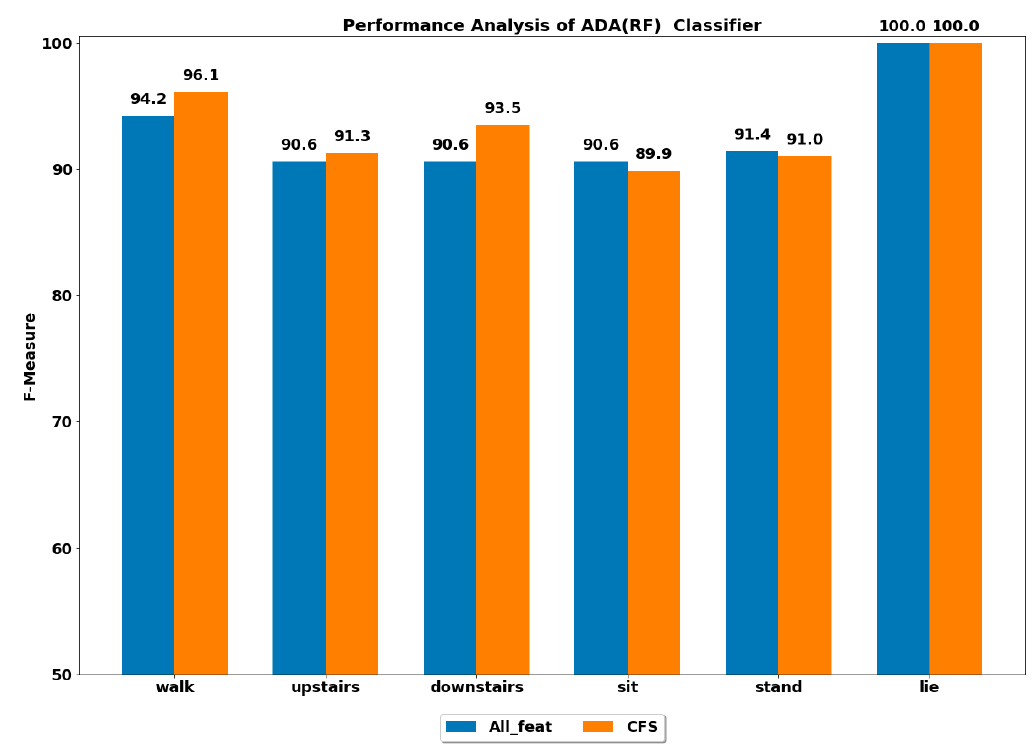
Figure 8. Performance analysis of ADA (RF) classifier with and without feature selection to classify set of ADLs.